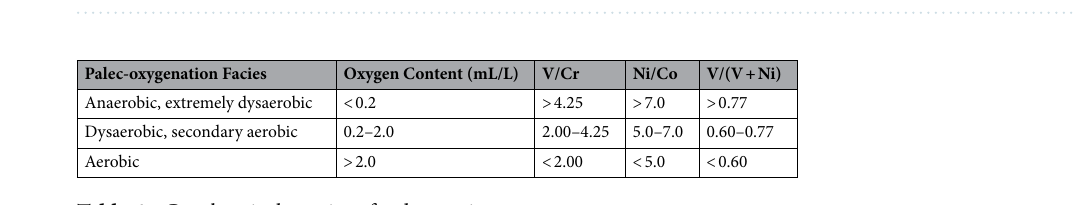
Table 6. Geochemical proxies of redox environment.